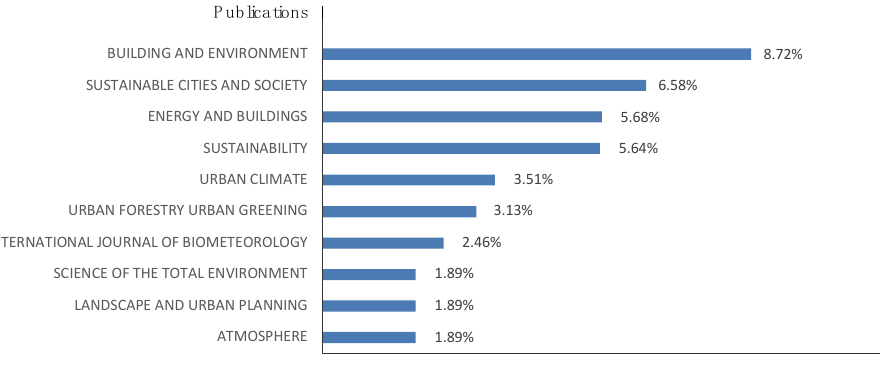
Figure 2. Percentage of urban microclimate papers by discipline (top 10).